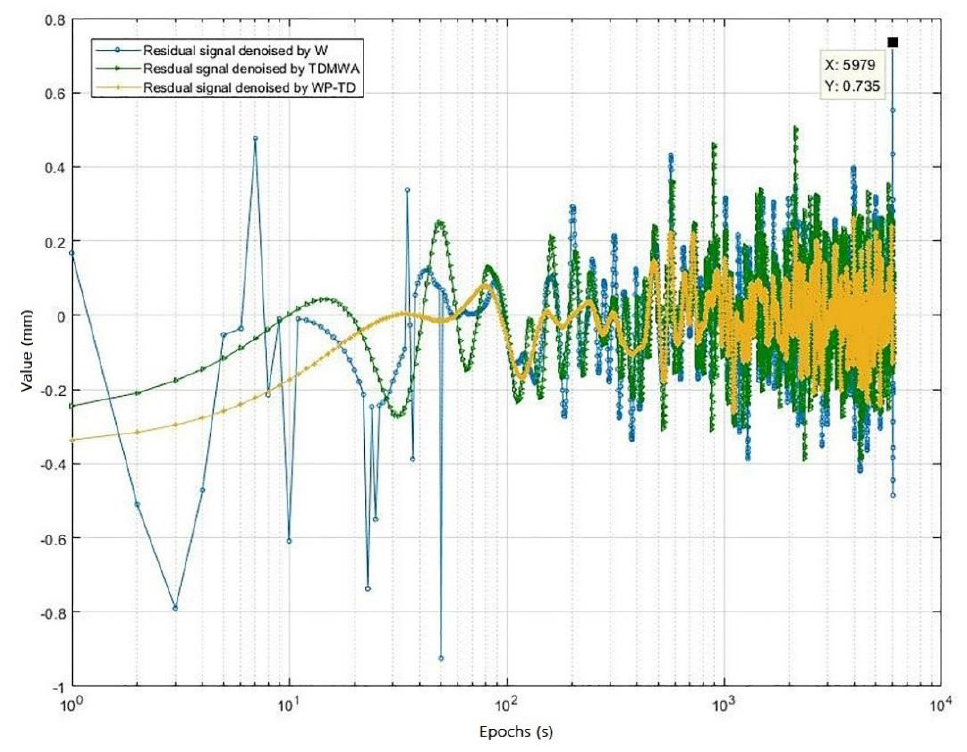
Figure 5. The residual signals generated by the three di ff erent algorithms.